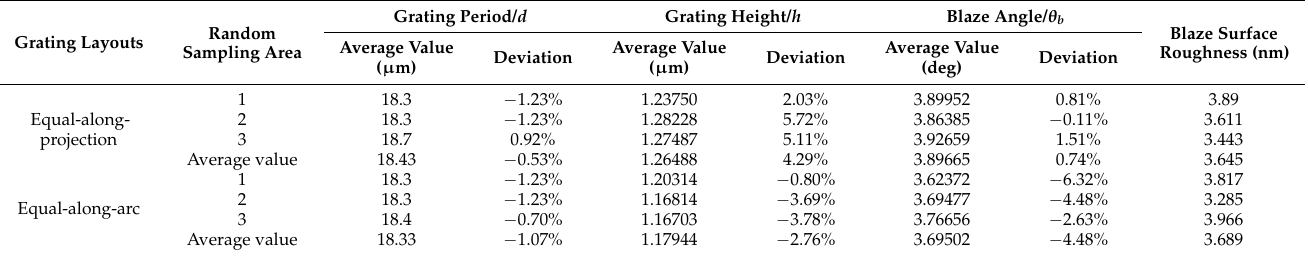
Table 4. Dimensions and roughness measurements of convex spherical blazed grating elements.